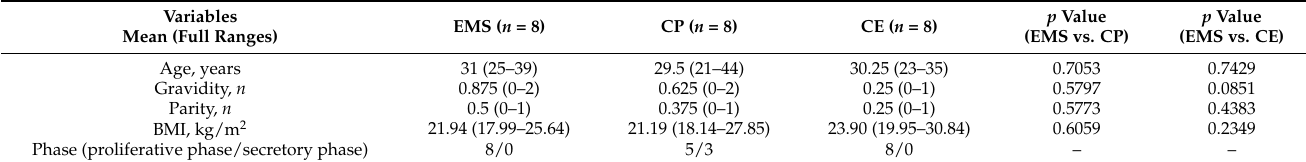
Table 1. Subject group characteristics—endometriosis (EMS), control PF (CP), and control en- dometrium